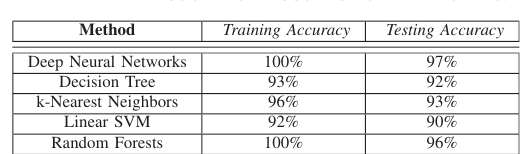
Fig. 9. Action: Violent